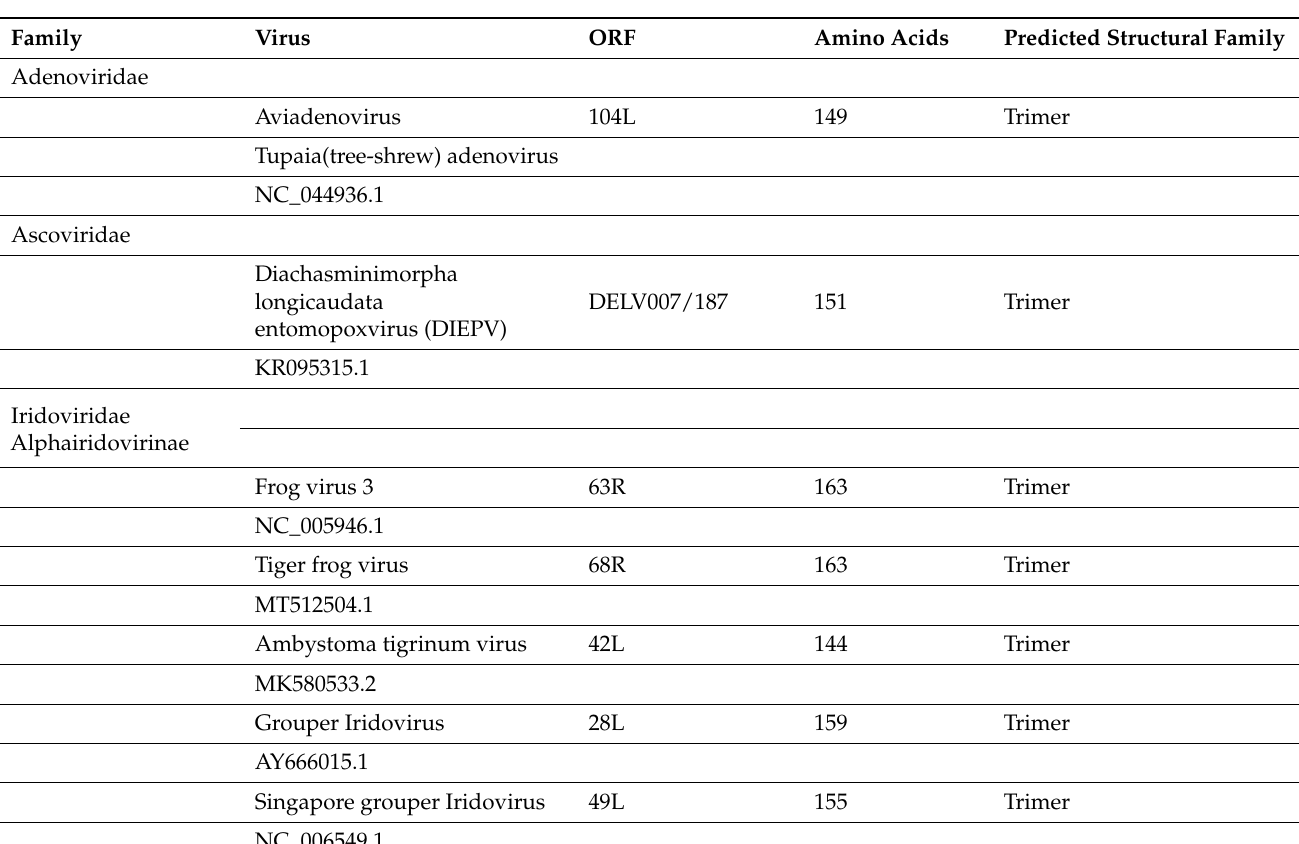
Table 1. Putative dUTPases based on DNA sequencing and annotation. Amino Acids Predicted Structural